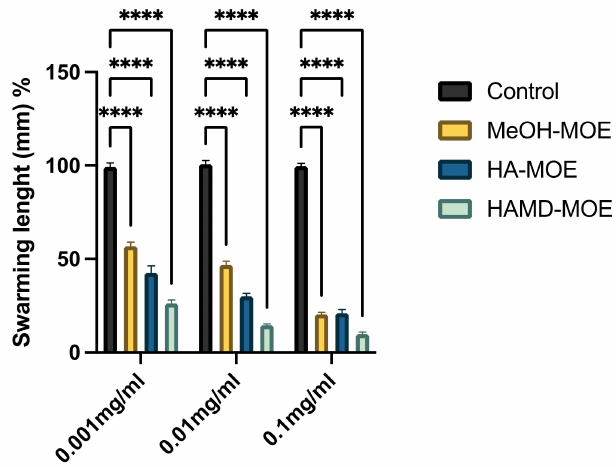
Figure 2. Effects of MOEs on swarming motility. The Xcc movement is measured in mm; the measure- ment of the swarming area was taken from the point of inoculation and presented as the percentage compared to the control. Data are the mean of 3 independent experiments performed on triplicate (mean +/ − standard deviation), and values are represented as a percentage; **** p -values < 0.001.